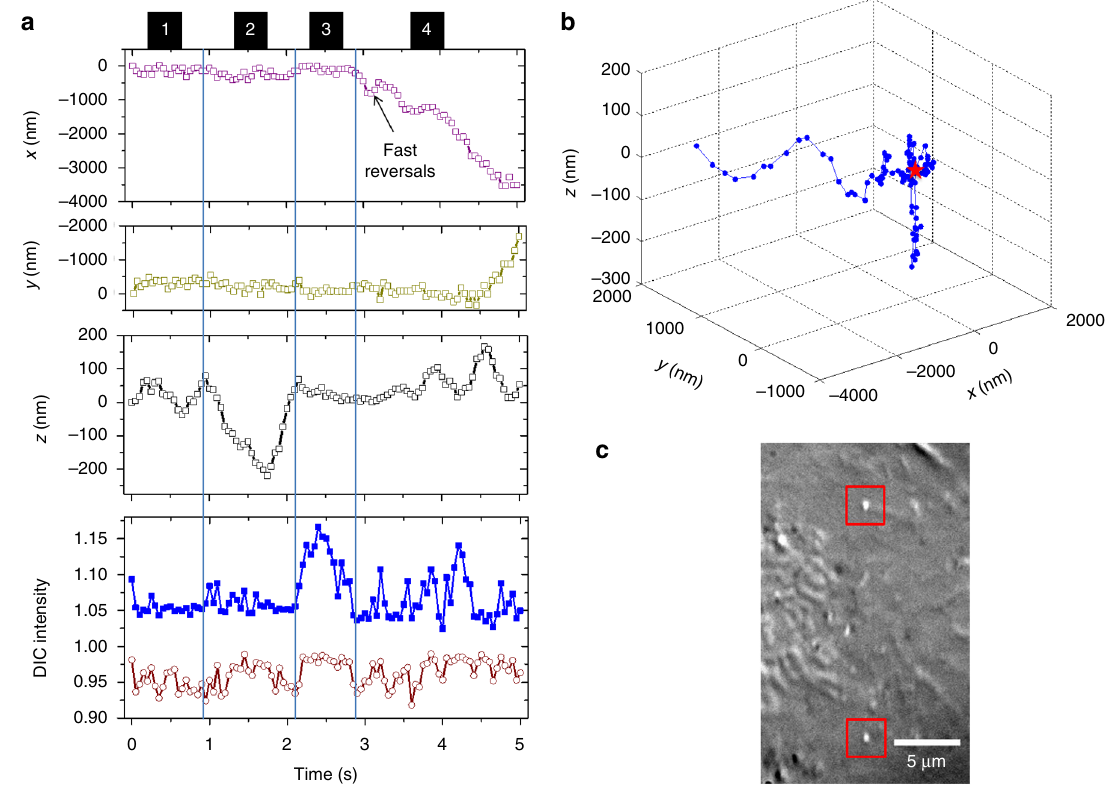
Fig. 4 Intracellular transport of a nanorod-containing vesicle in a living A549 cell. a The time series of the x , y , and z displacement, relative DIC intensities and orientation angles of the gold nanorod. The entire recording is divided into four segments as labeled: (1) searching for a track; (2) vertical transport; (3) a big turn; (4) lateral transport with twisted up-and-down motions. b The 3D trajectory of the cargo. The starting position (0, 0, 0) is highlighted by the red star. c Parallax-DIC image of the 5D-SPT of the gold nanorod of interest as indicated by the red